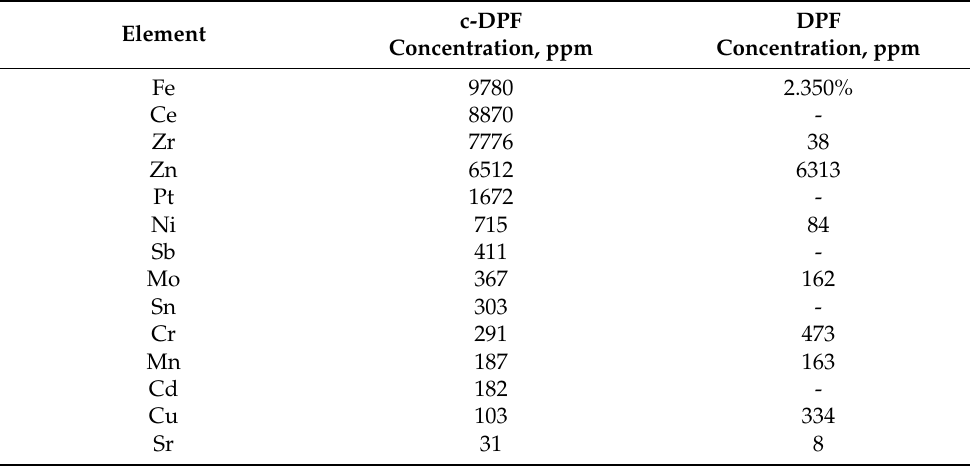
Table 1. XRF analysis of c-DPF and DPF powder